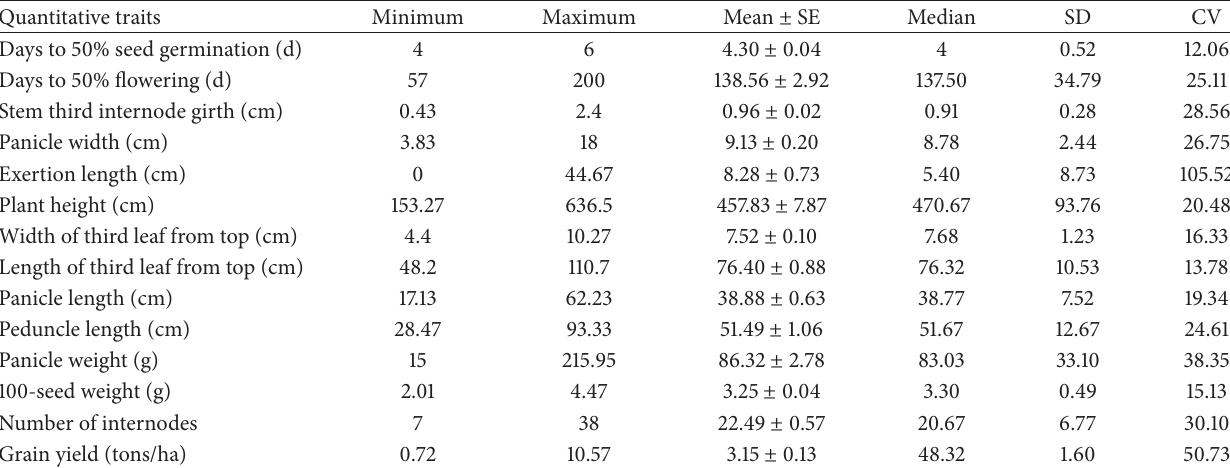
Table 2: Descriptive statistics of 14 quantitative agromorphological traits in 142 sorghum studied accessions. Quantitative traits